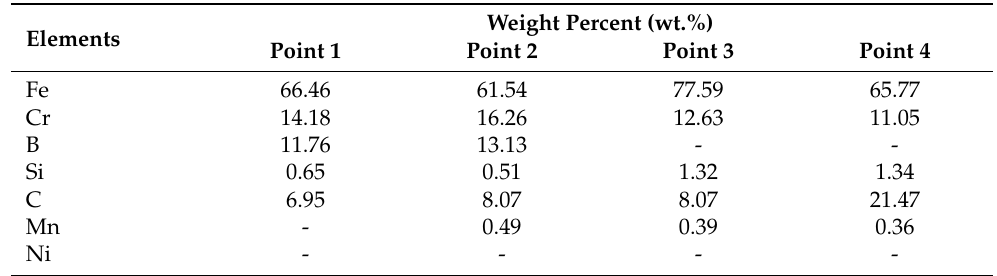
Figure 8. Higher-magni fi cation SEM micrograph for the coating C3. Table 4. EDX point scanning results of points (denoted by the white asterisks in Figure 8) in the coating